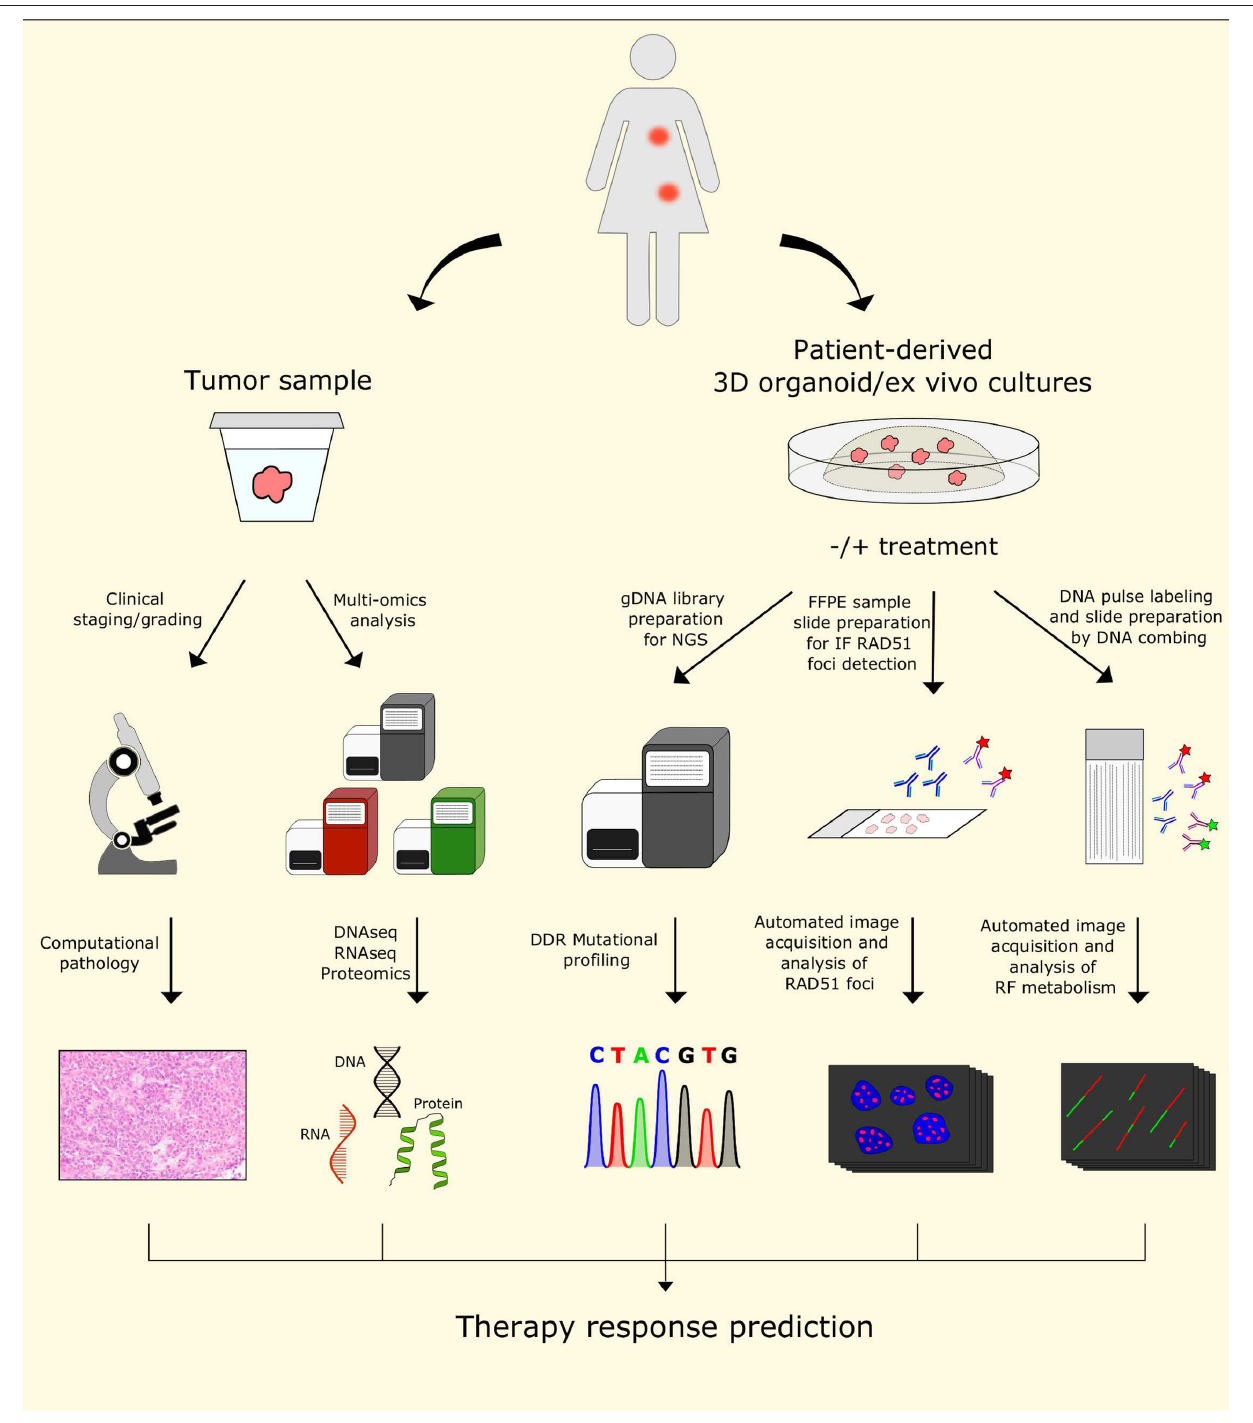
FIGURE 5 | Future perspectives for predicting personalized therapy outcome. The use of patient samples for histology and multi-omics analysis will remain valuable tools to characterize tumors. In addition, patient-derived 3D organoid/ ex vivo cultures may provide additional material for functional testing, such as RAD51 foci detection upon ionizing radiation, or DNA fiber analysis to probe for replication fork speed and/or stability. Together with the increasing knowledge of the importance of DDT and RF remodeling in anticancer drug response, these additional tools may allow automated functional analyses coupled with NGS profiling of DDR genes in patient-derived samples, providing the potential for designing personalized therapy strategies and predicting their outcomes in the future. DDR, DNA damage response; FFPE, formalin-fixed, paraffin-embedded; gDNA, genomic DNA; IF, immunofluorescence; NGS, next-generation sequencing; RF, replication fork.